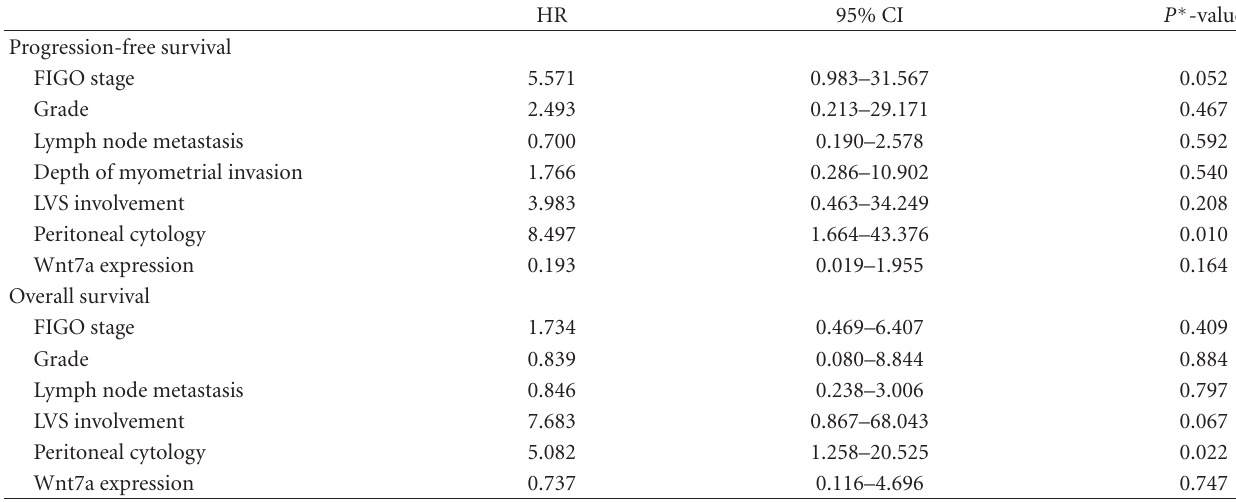
FIGO: International Federation of Gynecology and Obstertics; LVS: lymph vascular space; PFS: progression-free survival; OS: overall survival; HR: hazard ratio; CI: confidence interval and ∗ Cox regression test. and Wnt7a targeting molecules are warranted to validate the prognostic impact of Wnt7a expression on survival in endometrial